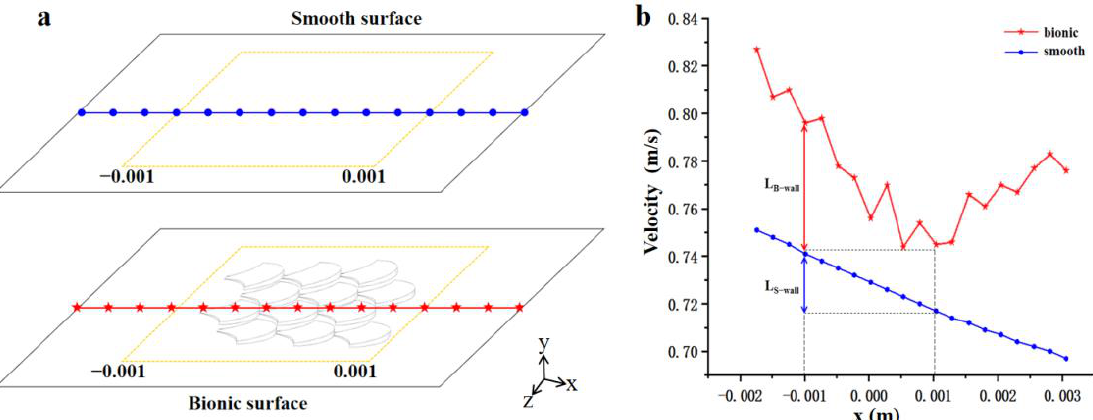
Figure 23. The change of velocity in the flow direction of smooth surface and bionic surface. ( a ) The position of the value line; ( b ) A diagram of velocity variation along the direction of flow.